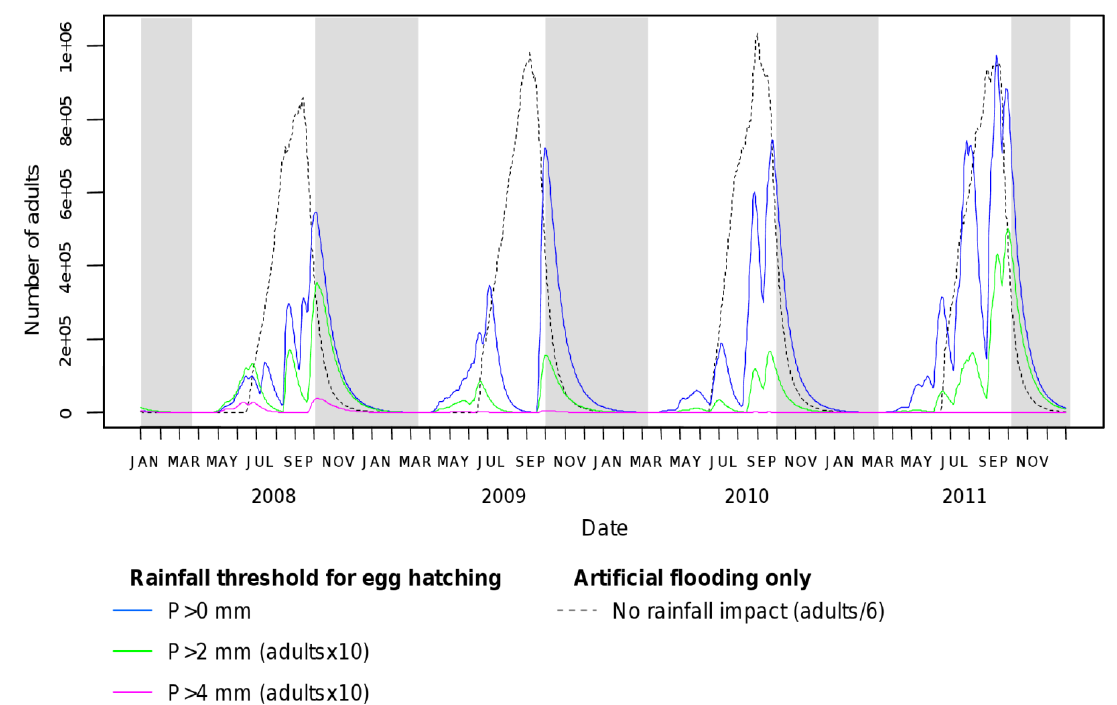
Figure 7. Aedes albopictus adult population dynamics with an egg hatching function driven either by rainfall or artificial flooding. Simulations were computed for different thresholds applied to daily rainfall for triggering egg hatching (P > 0 mm, P > 2 mm, and P > 4